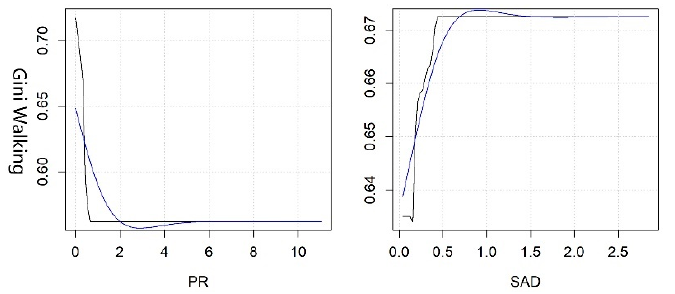
Figure 6. Nonlinear effects of various variables on the equity of PGSs by walking.